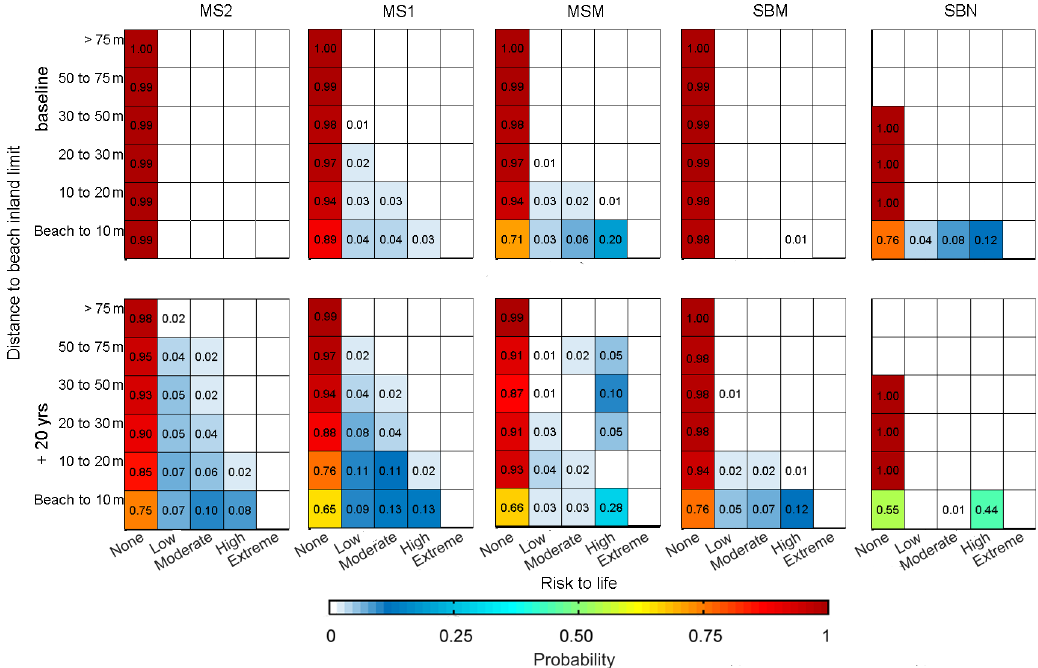
Figure 11. Probability distributions of the risk to life by inundation conditioned to different subareas (see Figs. 1 or 8 for locations) and the distance to the inner limit of the beach. Baseline and + 20-year time horizon of background shoreline retreat. Results must be read horizontally as individual histograms for each combination of area, distance, and